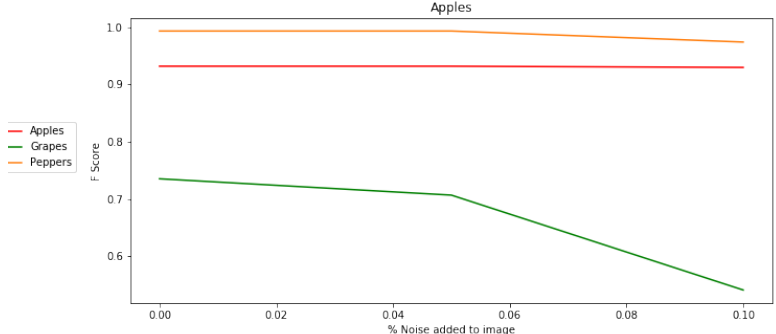
Figure 16. Sensitivity analysis: adding noise to STD stop condition.